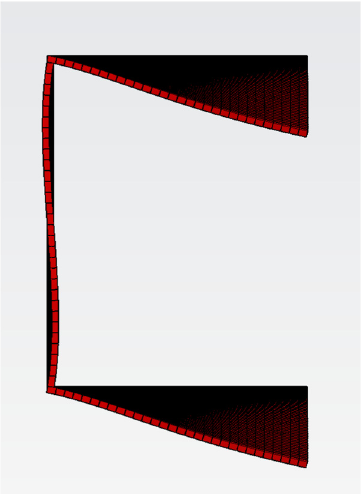
Figure 11. Local deformation of the flanges for Section #1, length = 100 mm, section discretisation 30 and longitudinal discretisation of 60.